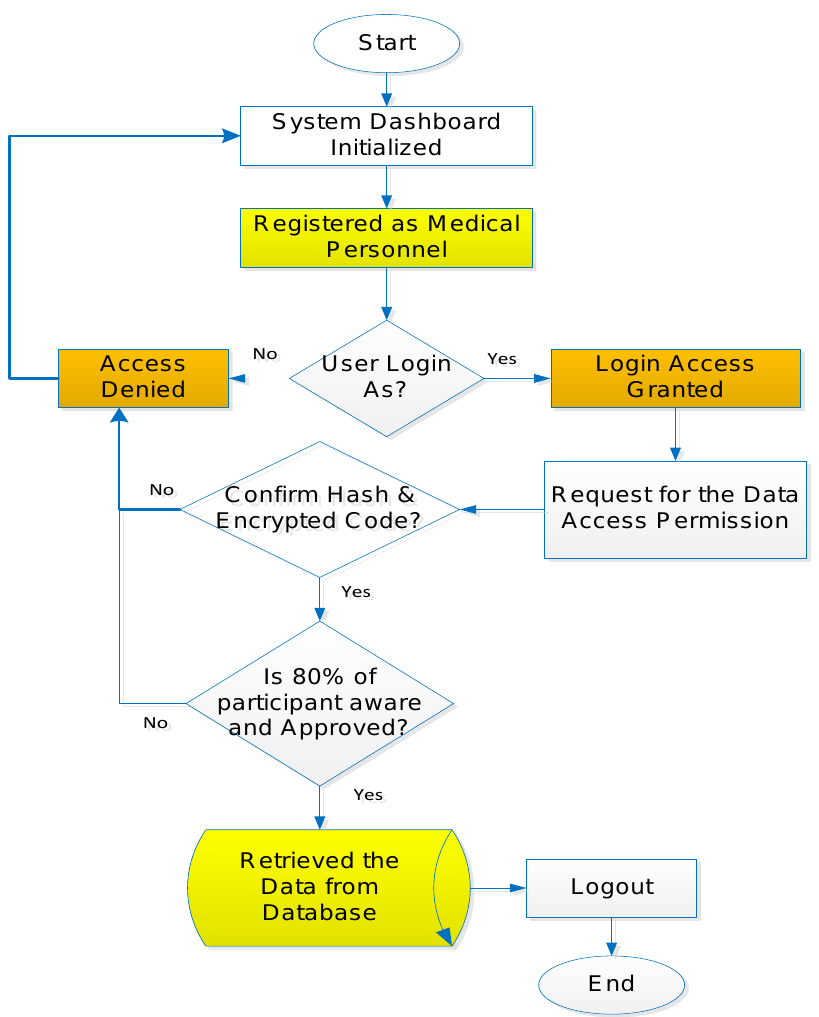
Figure 7. A secure public-permissioned blockchain database system for fog layer information.